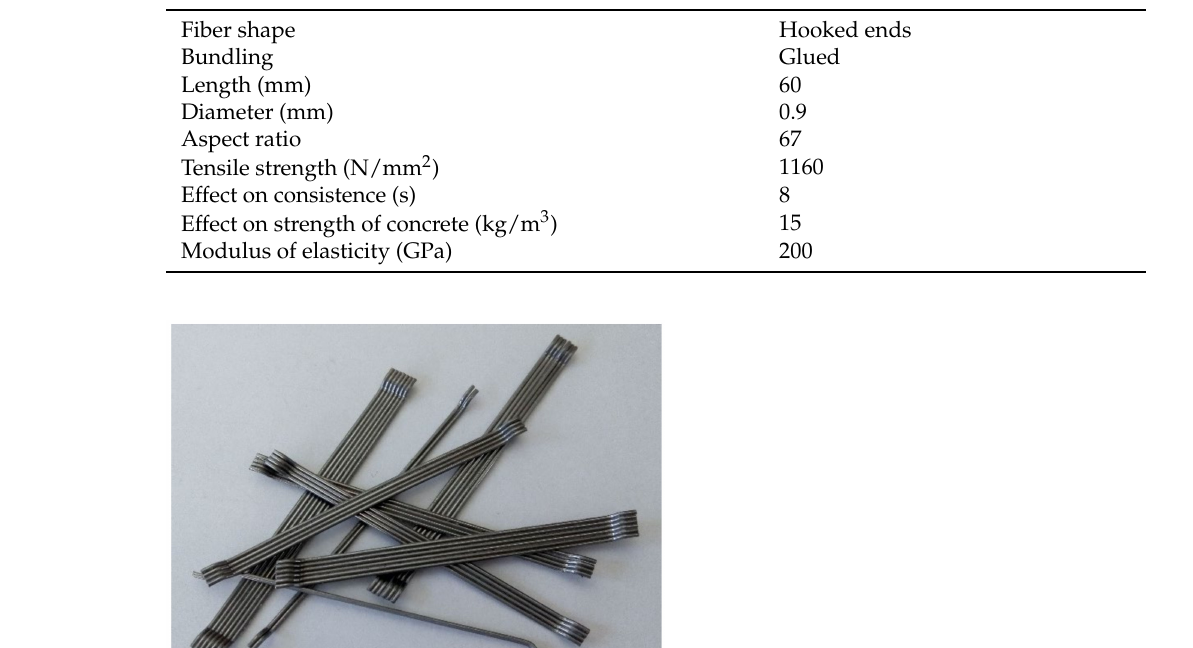
Table 2. Material properties of Dramix ® 3D 65/60 BG.